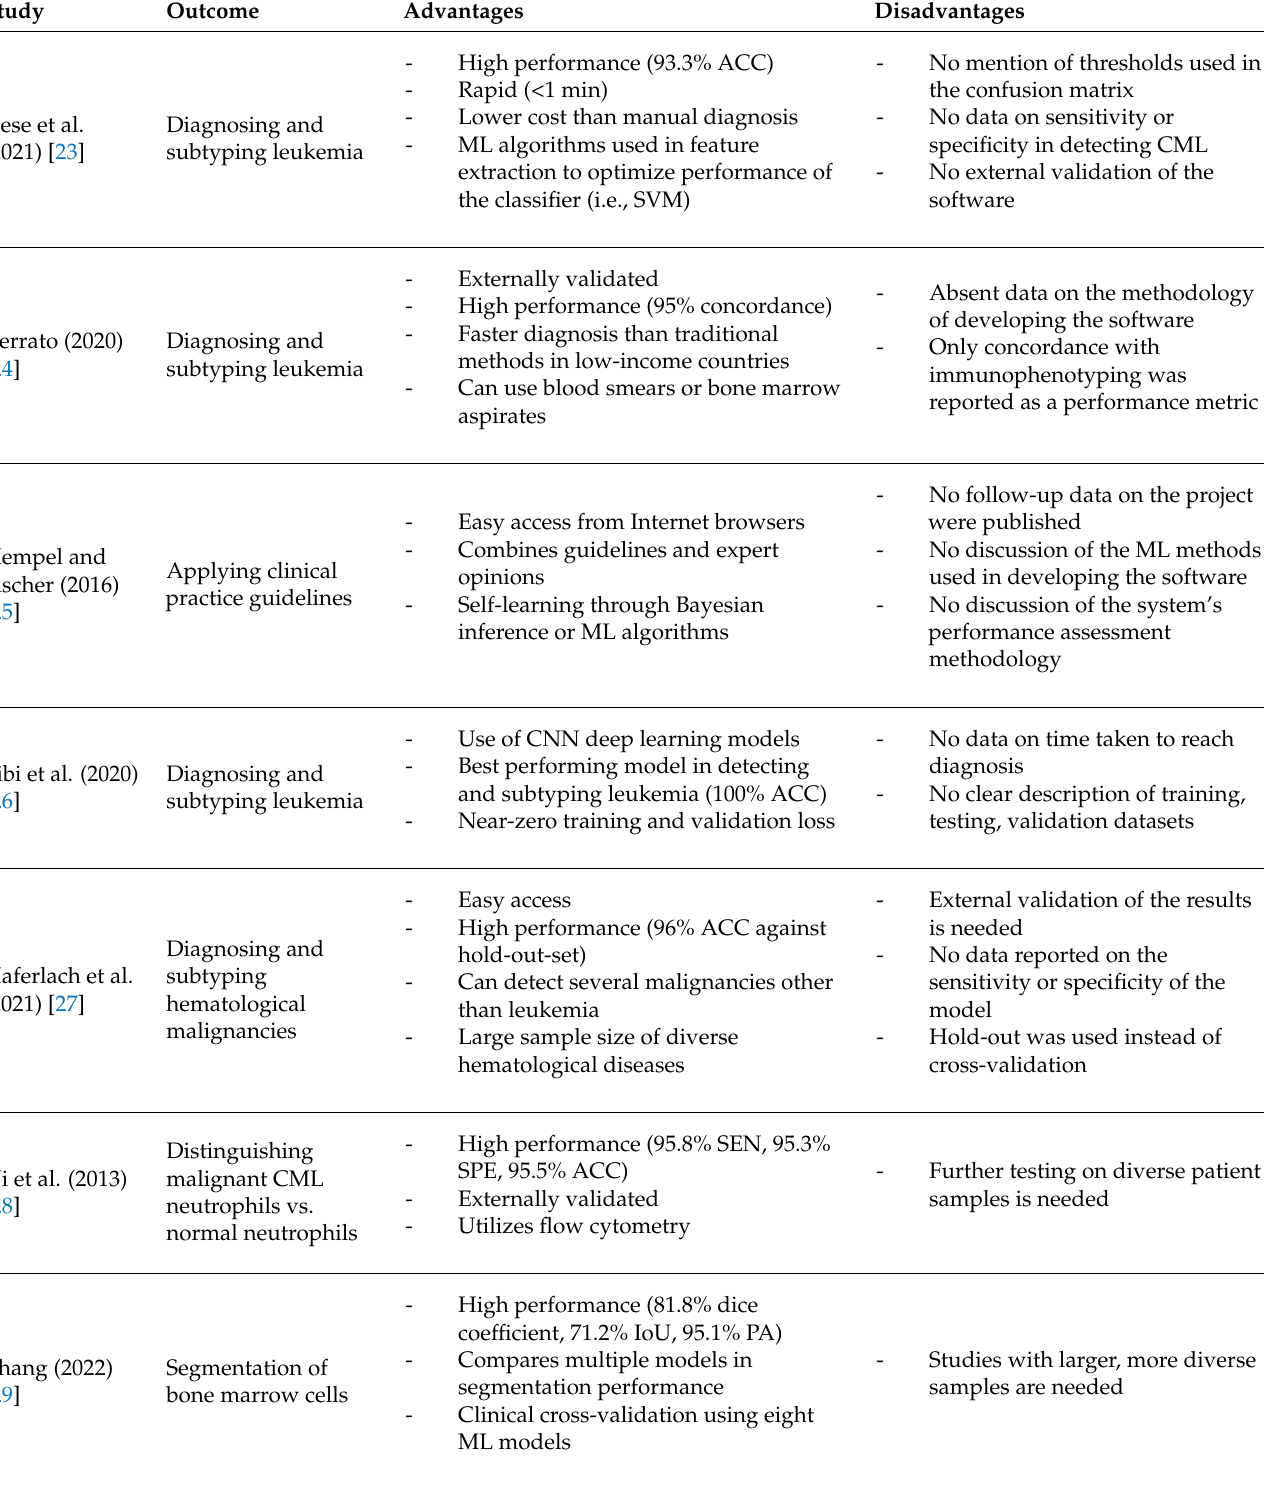
Table 1. Data extraction summary of the included